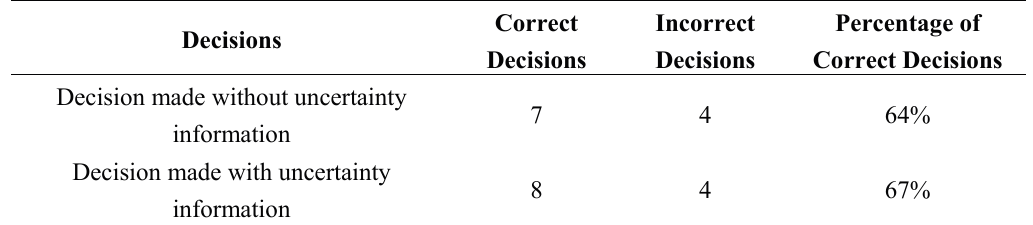
Table A4. Observed frequencies of correct and incorrect decisions made with and without the uncertainty information by participants in neither group.